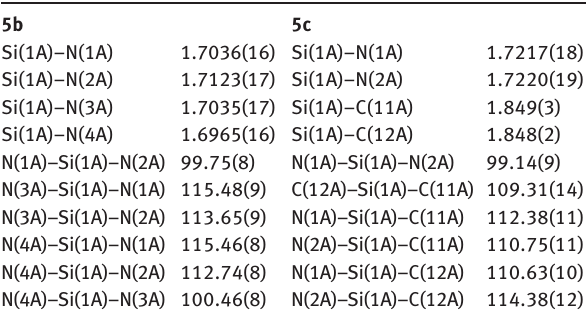
Table 5: Selected geometric parameters (Å, °) of 5b and 5c